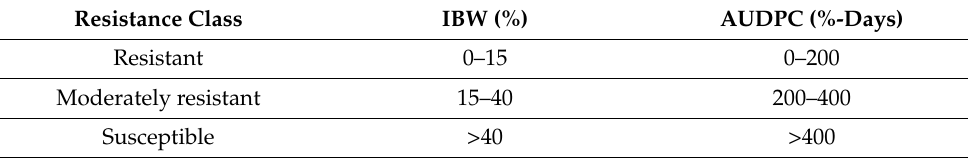
Table 1. Resistance classification of amaranth varieties used in this